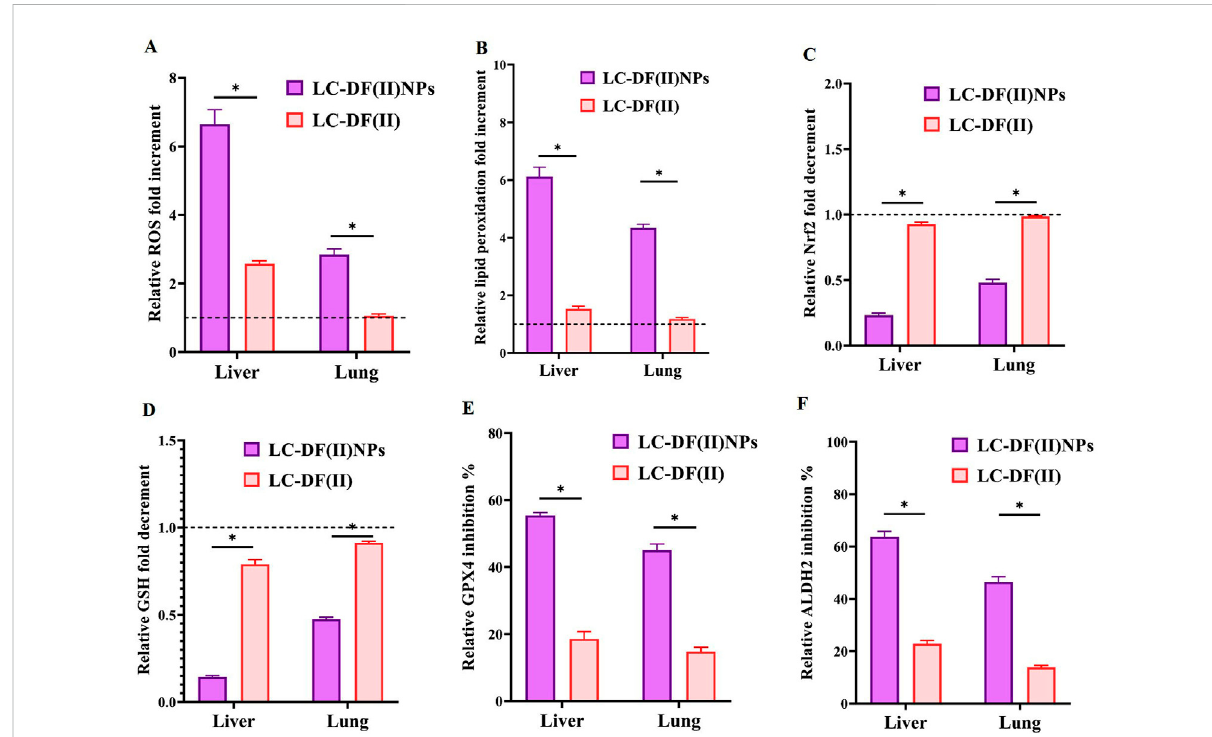
FIGURE 4 Lipid peroxidation generation-dependent pro-oxidant activity of DF(II) complexesin tumor tissues relative to the untreated LC groups. Relative fold increment in (A) reactive oxygen species (ROS) and (B) lipid peroxidation. Relative fold decrement in (C) Nrf2 transcriptional activation and (D) glutathione (GSH), All treated group values were normalized to the untreated LC group values, which were set at 1 as demonstrated by the dashed line, with values above 1 indicating fold increment and values below 1 demonstrating fold decrement. Relative inhibition percentages of lipid peroxide-detoxifying enzymes, including (E) glutathione peroxidase (GPX)4 and (F) aldehyde dehydrogenase (ALDH) 2. Data are shown as mean ± SEM. LC-DF(II) NPs group was compared to LC-DF(II) groups, considering statistically signi fi cant at p ≤ 0.05*, ≤ 0.005**, and ≤